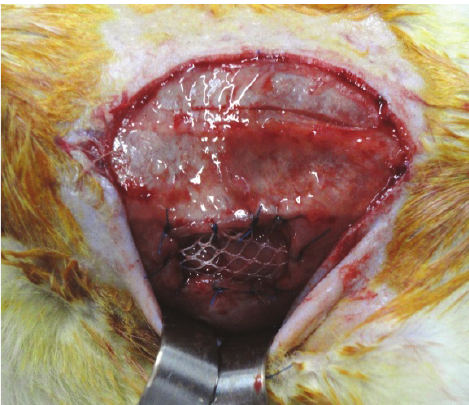
FIGURE 1 – Final aspect of injury repair using polyester with collagen mesh.